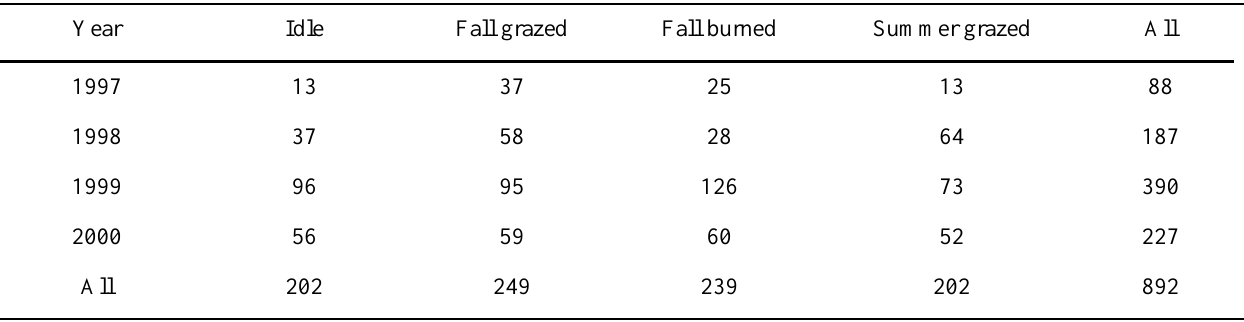
Table 1. Number of American Coot ( Fulica Americana ) nests, by year and treatment, used in analysis of nest survival at Grays Lake, Idaho,